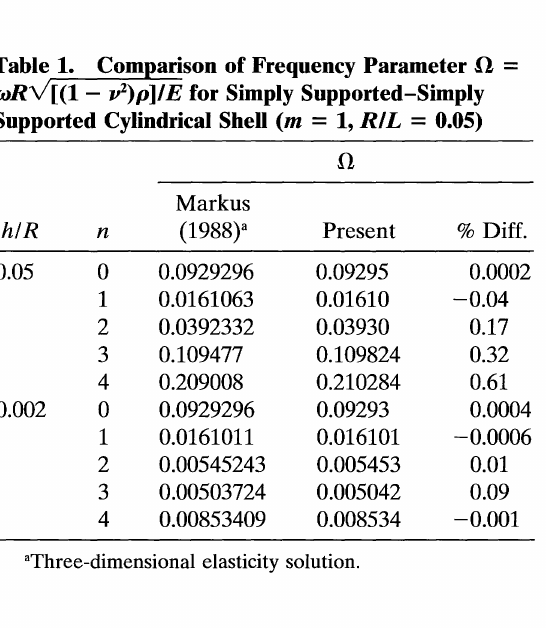
Table 3. Comparison of Frequency Parameter 0 = wRY[(I- ,r)p]IE for Clamped-Simply Supported Cylindrical Shell (m = 1, LIR = 20; hlR = 0.002,